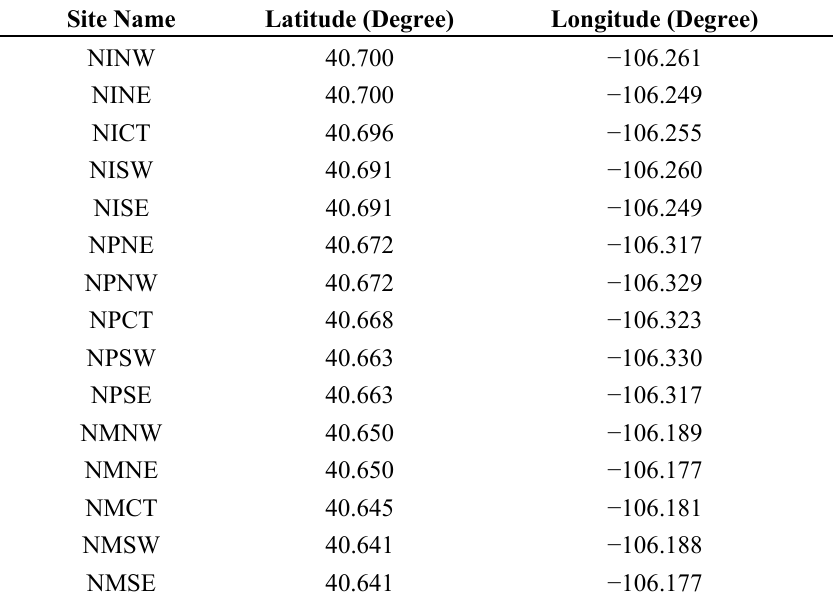
Table 1. Locations of in situ measurement